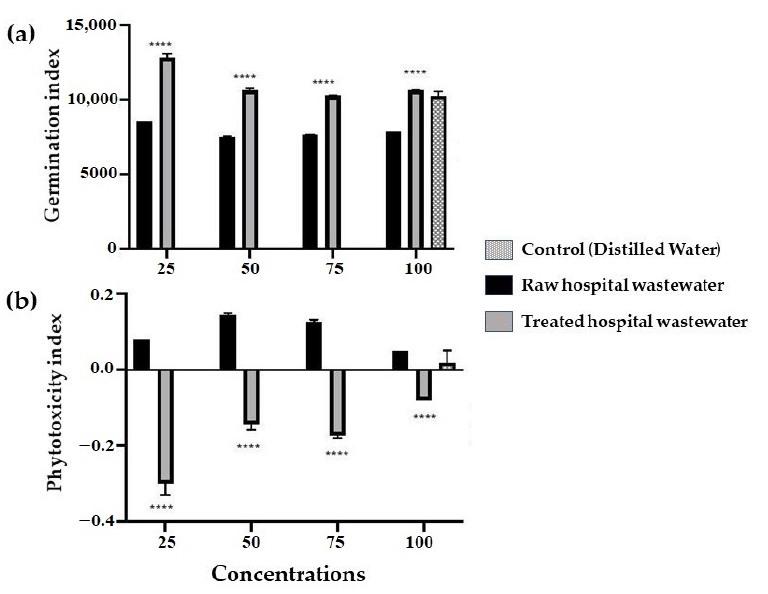
Figure 6. ( a ) Germination indices of Cauliflower seeds grown in untreated and treated hospital wastewaters; ( b ) Phytotoxicity indices of Cauliflower seeds grown in untreated and treated hospital wastewaters. Significance (Welch’s test) between treated and untreated hospital wastewater is indicated by p < 0.0001